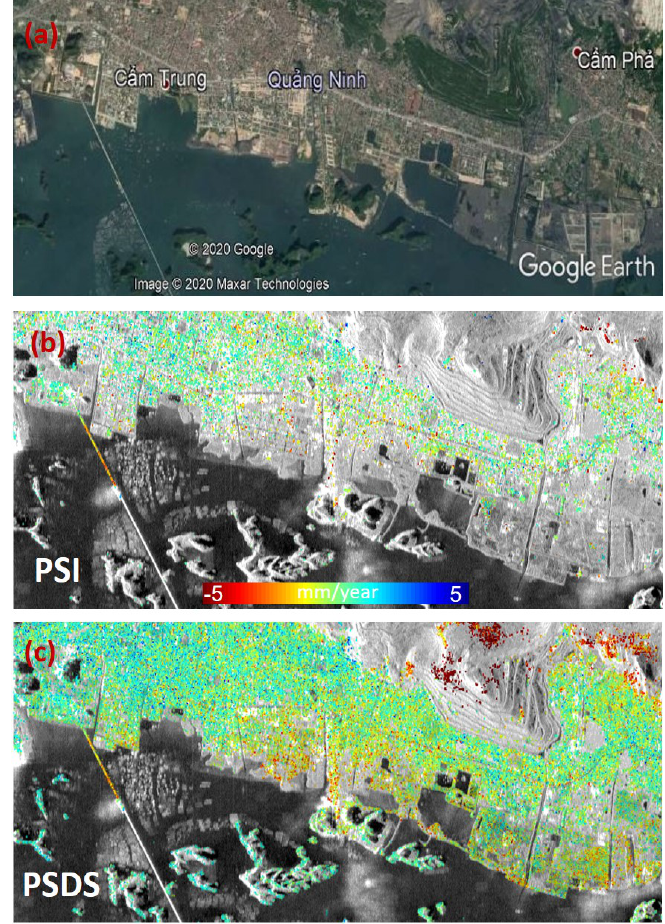
Figure 2. An example of the velocity map estimated using SAR Sentinel-1 images over Quang Ninh province area about 4 km × 10 km. ( a ) The same area sensed by the optical image from Google Earth. ( b , c ) The velocity (mm/year) map was processed by the PSI and PSDS techniques,